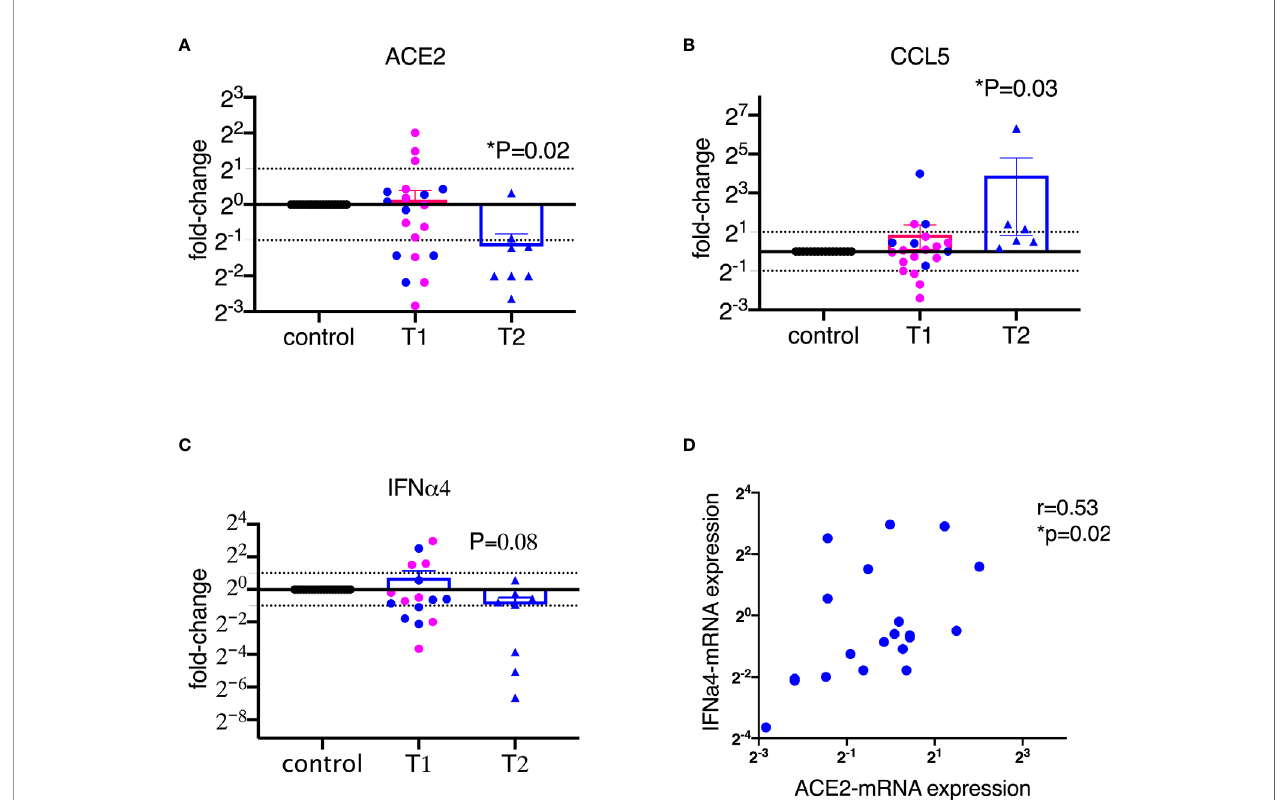
FIGURE 1 | SARS-CoV-2 spike protein suppressed the mRNA expression of ACE2 and type I interferon in lung bronchoalveolar lavage from naïve macaques. Primary lung bronchoalveolar lavages from naïve rhesus macaques were cultured with 1 (T1) or 2 (T2) µg/ml of spike protein S1 for 20 hrs (n=20 and n=6 or 8, respectively). After the supernatants were collected, the cells were lysed with trizol and RNAs were isolated. After reverse transcription, macaque-speci fi c primer/ probe sets were used to measure the mRNA expression levels of ACE2, CCL5, and interferon a 4 (A – C) . Data are shown as mean±SEM. Each dot presents one animal. The blue color indicates the samples from T1 that have corresponding cultures from matched animals in T2. Wilcoxon signed rank tests were used to calculate the p values. (D) ACE2 positively correlated with interferon a 4 in lung bronchoalveolar lavage. Spearman R and p values are